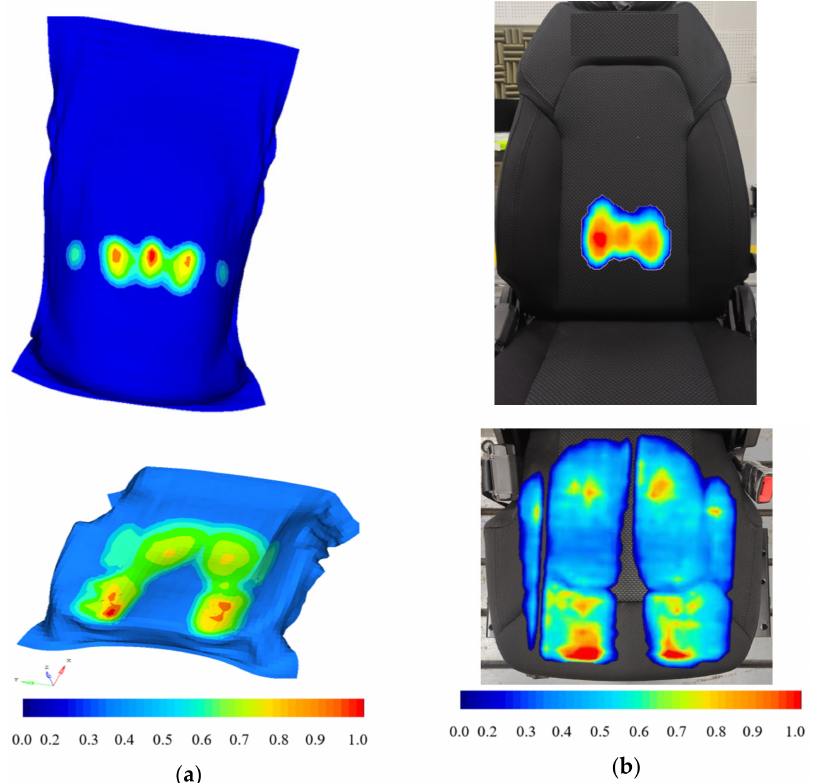
Figure 9. ( a ) The backrest and cushion simulation pressure map; ( b ) The backrest and cushion test pressure map.